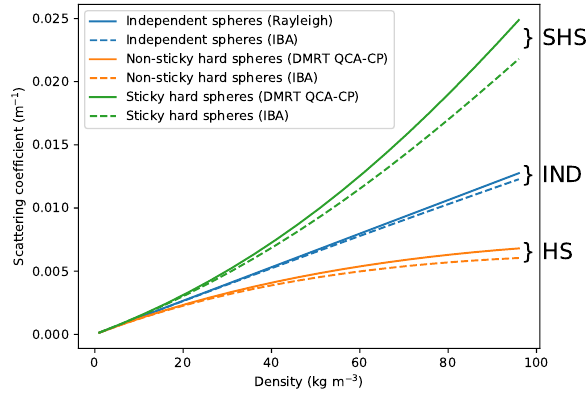
Figure 3. Scattering coefficient by several electromagnetic theo- ries (independent spheres, IND; non-sticky hard spheres, HS; sticky hard spheres, SHS) as a function of density for sparse media de- scribed by various microstructures. The sphere radius is